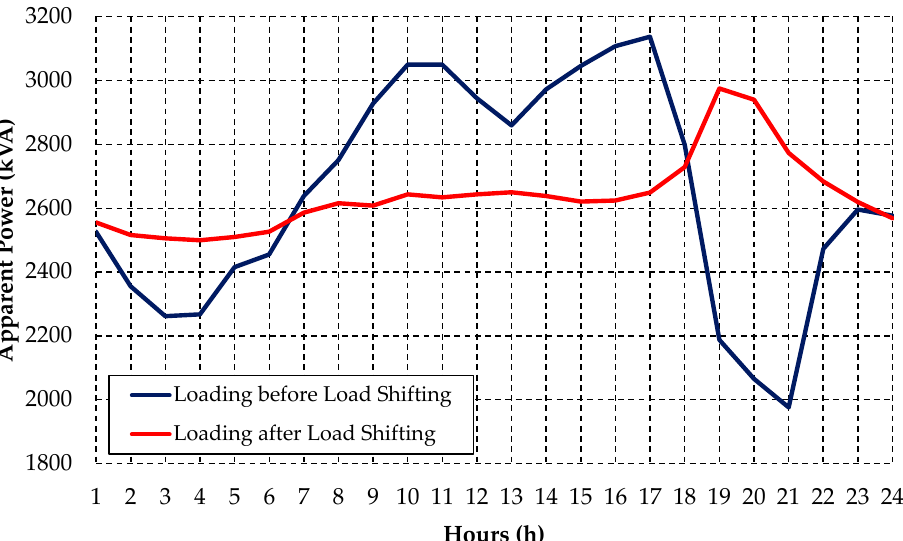
Figure 27. Rural Feeder C loading before and after load shifting for irrigator customers. Source: The authors.